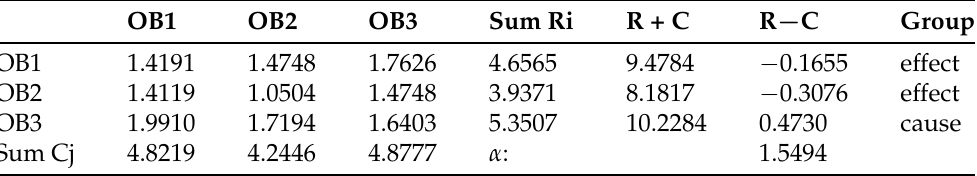
Table 15. Total relation and direct–indirect influence matrix for intra-organizational